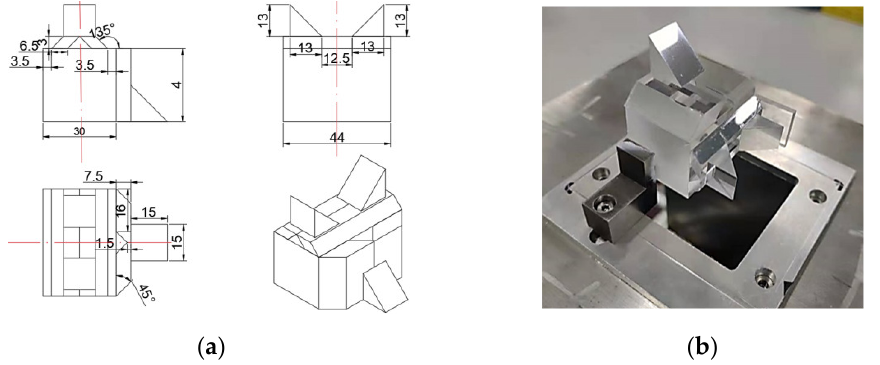
Figure 7. Detailed dimension picture and actual picture of prism assembly. ( a ) Dimension drawing of prism assembly; ( b ) Actual picture of prism assembly.